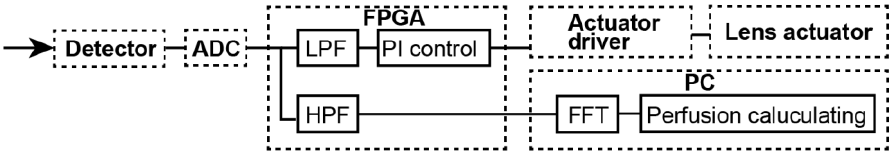
Figure 5. Signal processing flow for motion-tracking and perfusion calculations. The analog signal (sampling rate: 1 × 10 5 samples/second) is low-pass-filtered (20 Hz, 3 dB) for feedback control and high-pass-filtered (1 kHz, 3 dB) for perfusion measurements.